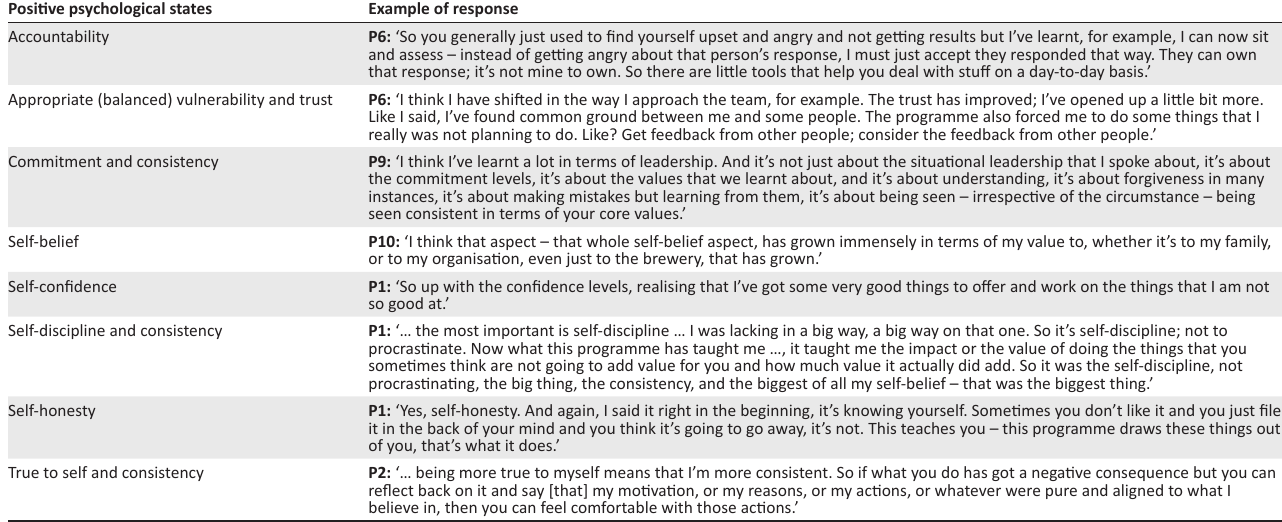
TABLE 1: Examples of development of positive psychological states. Positive psychological states Example of